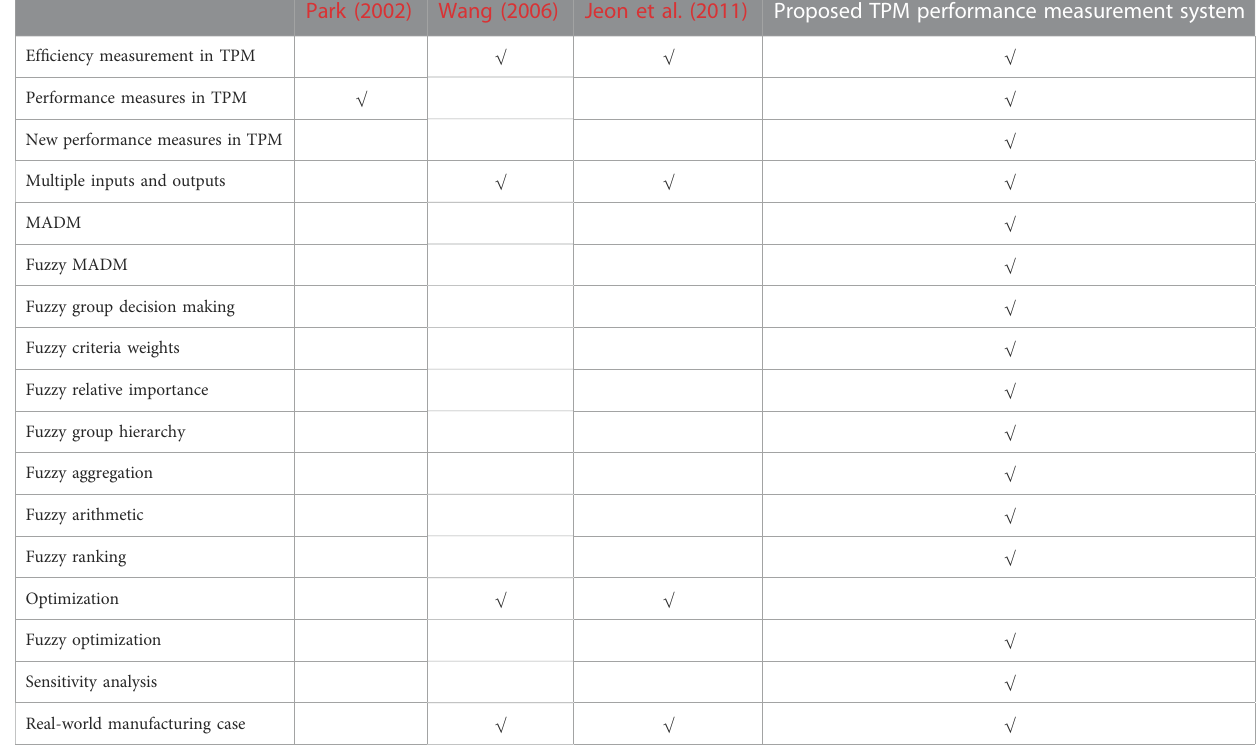
TABLE 1 The positioning of the proposed TPM